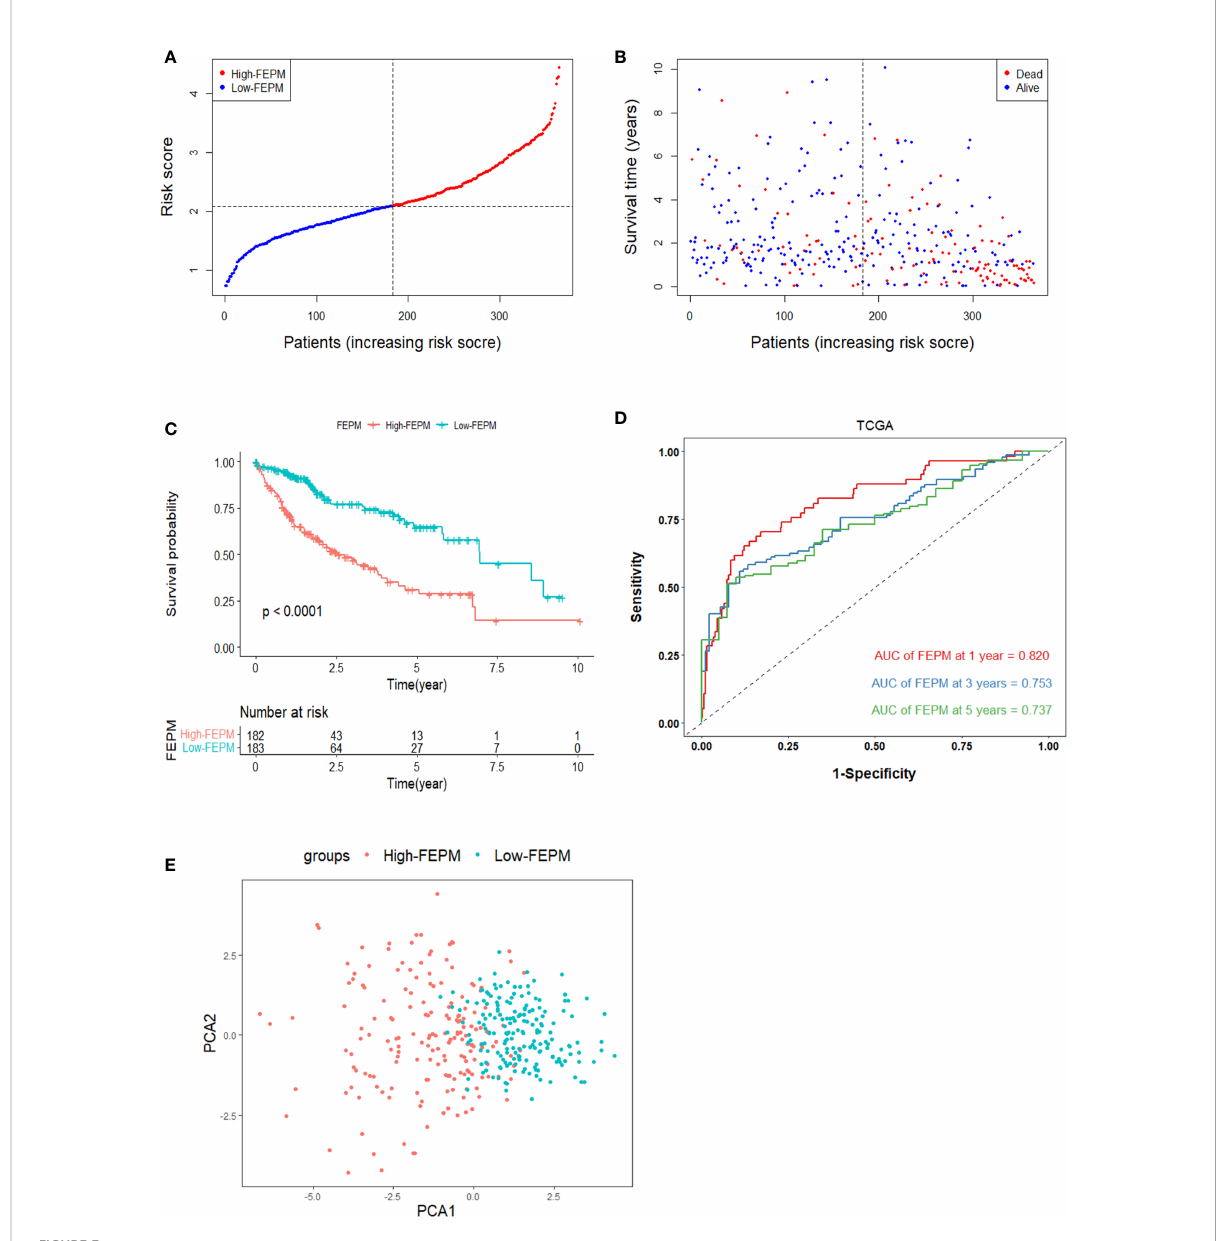
FIGURE 3 Survival analysis of FEPM in the TCGA cohort. (A, B) Distributions of FEPM scores and survival status of HCC patients in the TCGA cohort. (C) Kaplan – Meier curves showed that patients in the high-FEPM group had worse prognosis than those in the low-FEPM group in the TCGA cohort. (D) ROC curves of FEPM for predicting the 1/3/5-years survival in the TCGA cohort. (E) PCA plots of the TCGA cohort based on